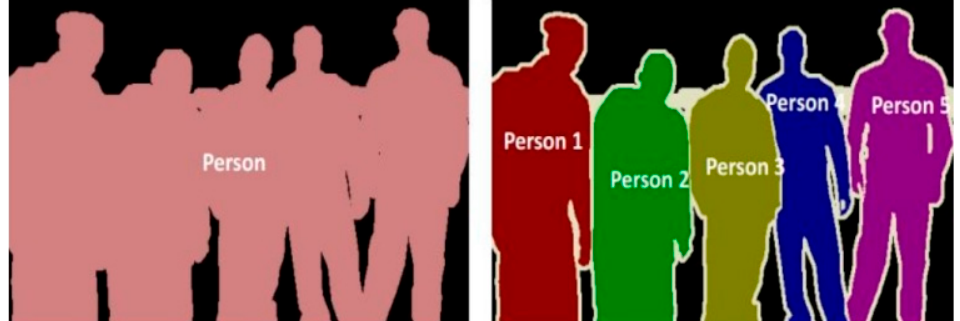
Figure 2. Comparison of semantic segmentation ( left ) and instance segmentation ( right ).